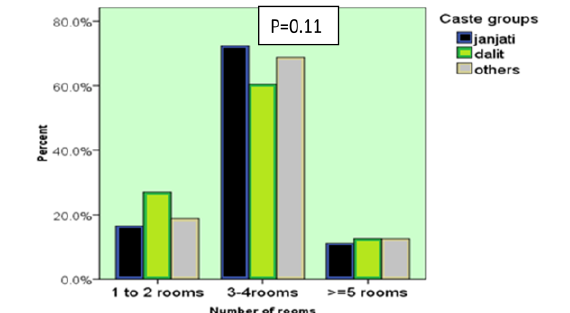
Fig.2.Distribution of rooms among different caste